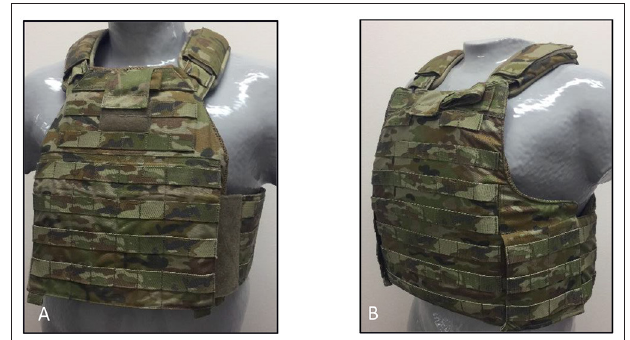
FIGURE 1 | Current Australian body armour is the Tiered Body Armour System (TBAS) V4.4, issued to personnel in either Tier 2 (A) or Tier 3 (B) . The same size hard plate and soft armour inserts are used in both systems. Tier 3 affords slightly greater protection to the solider, as shown by increased soft armour coverage on the side